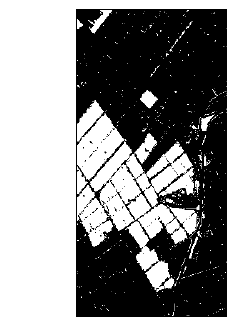
Figure 10. Multiple CD accuracies obtained by the proposed CD approaches based on BS-DR and the reference methods (Yancheng dataset). The unsupervised k -means and FCM were applied on the compressed direction of X S (i.e., X S - θ ) and the supervised SVM-based and RaF-based approaches were applied on the uncompressed X S . Baseline results on X D in the proposed approaches and in two reference methods are shown as dashed lines for comparison purposes.